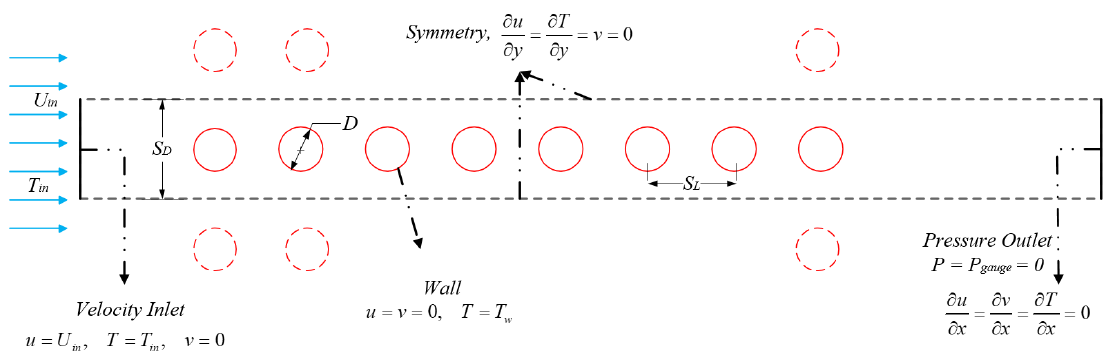
Figure 1. Geometry and boundary conditions.